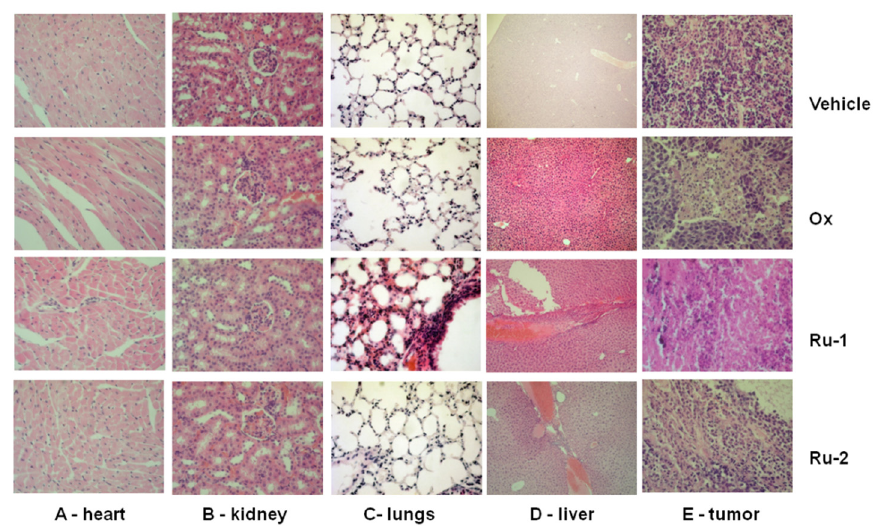
Figure 10. Histological examination. Representative hematoxylin and eosin staining of ( A ) heart, ( B ) kidney, ( C ) lungs, ( D ) liver tissue, and ( E ) tumor sections (magnification at 400×, only liver tissue sections on 100×).